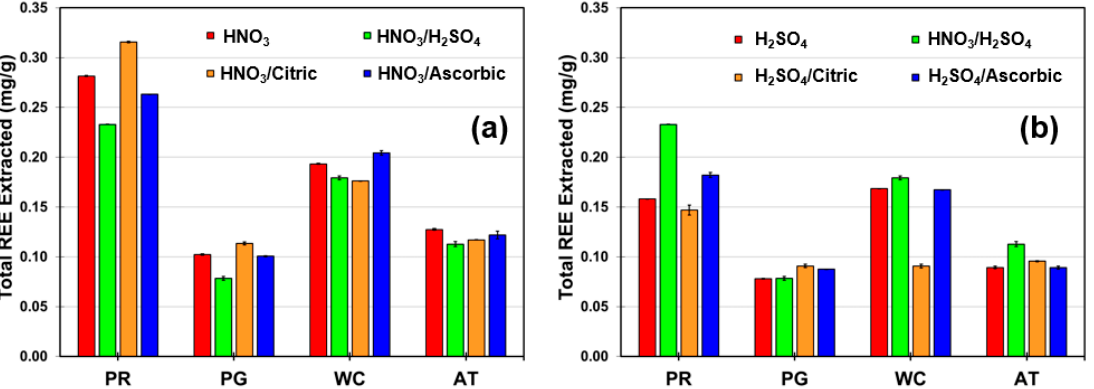
Figure 2. Extracted REEs using mixtures of ( a ) HNO 3 , ( b ) H 2 SO 4 , citric acid, and ascorbic acid.